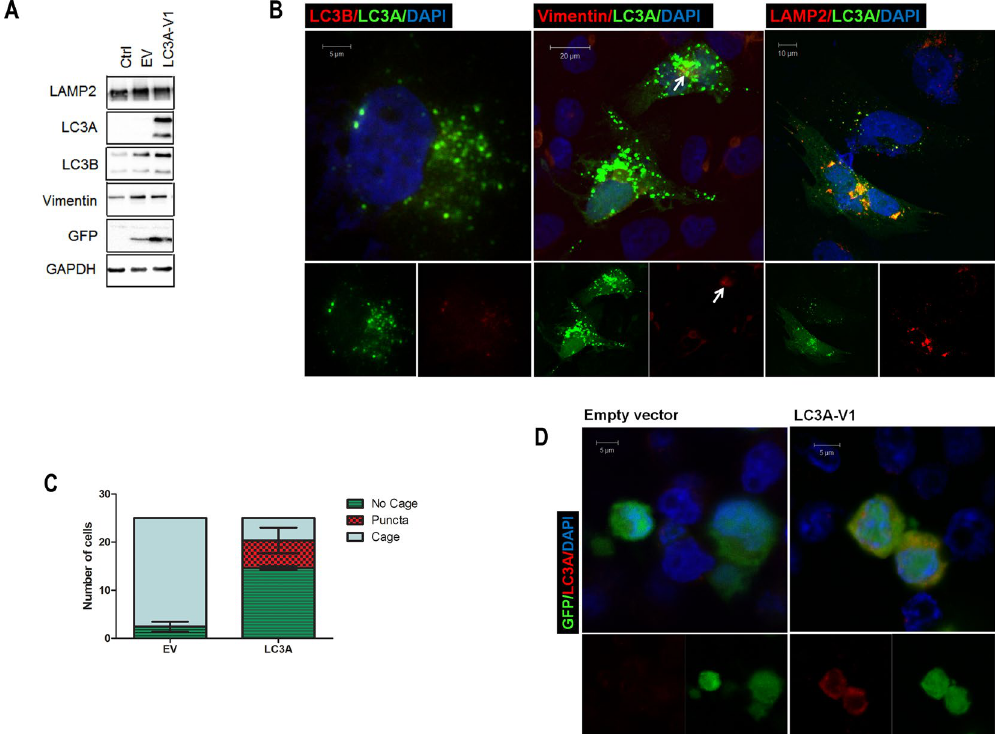
Figure 4. Expression of LC3A induces the formation of LC3A positive autophagosome. ( A ) Western blot analysis of CCHE-45 transfected with empty vector or LC3A-V1 for 48 hours. GAPDH was used as a loading control. ( B ) Immunofluorescence analysis of CCHE-45 cells transfected with empty vector or LC3A-V1. Cells were co-immunostained with mouse anti-vimentin (red) and rabbit anti-LC3A (green), mouse anti- LAMP2 (red) and rabbit anti-LC3A (green) or mouse anti-LC3B (red) and rabbit anti-LC3A (green). Staining was visualized using Alexa Fluor 488 goat anti-rabbit antibody and Alexa Fluor 555 goat anti-mouse. ( C ) Quantification of aggresomes vimentin cage following LC3A-V1 transfection. Vimentin cage structures were counted manually in GFP positive cells. LC3A-V1 transfected cells GFP positive were also examined for LC3A puncta. Bars represent the average value from three independent experiments. Error bars represent ± SEM. ( D ) Immunofluorescence analysis of HEK293-T cells transfected with empty vector or LC3A. LC3A expression was examined using rabbit anti-LC3A (red) in GFP positive cells. EV = empty vector, Ctrl = control non- transfected